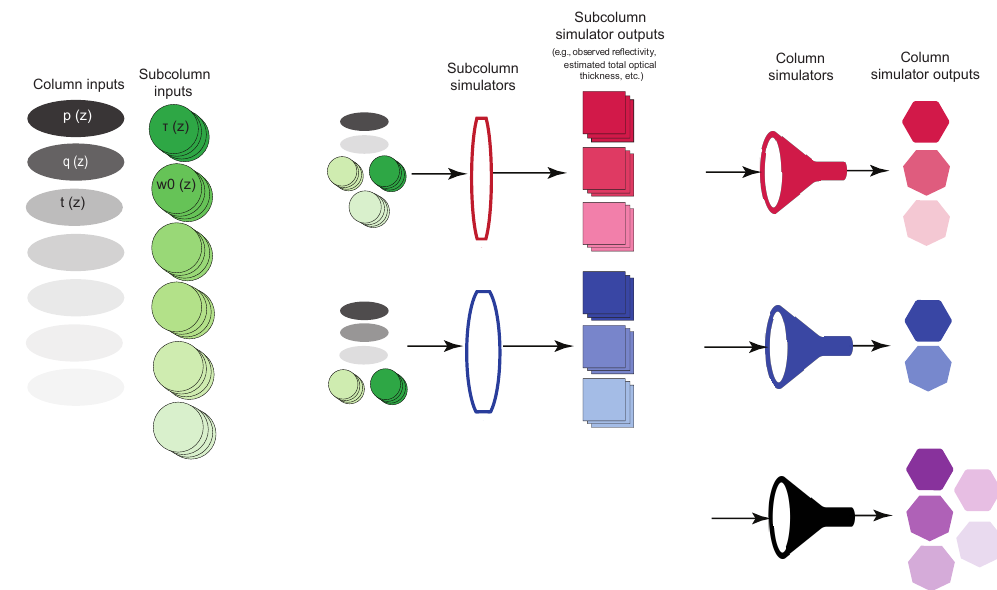
Figure 1. Organizational view of COSP2. Within each grid cell host models provide a range of physical inputs at the grid scale (grey ovals, one profile per variable) and optical properties at the cloud scale (green circles, Nsubcol profiles per variable). Individual subcolumn simulators (lens shapes, colored to indicate simulator types) produce Nsubcol synthetic retrievals (squares) which are then summarized by aggregation routines (funnel shapes) taking input from one or more subcolumn